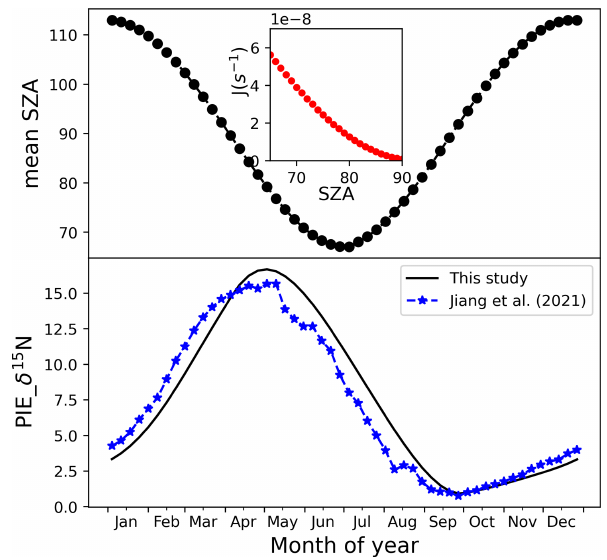
Figure 3. Upper panel: weekly average solar zenith angle (SZA) (shown in black circles) at Summit within a year and nitrate photol- ysis rate constant ( J ) as a function of SZA (shown in red circles in the inset). The summertime J value is from Galbavy et al. (2007), and we scaled it with SZA to obtain J values for other months for simplicity. Lower panel: calculated PIE using Eq. (3) and that from the TRANSITS model in Jiang et al. (2021); weekly snow accu- mulation rates were from bamboo stake measurements by Dibb et al.